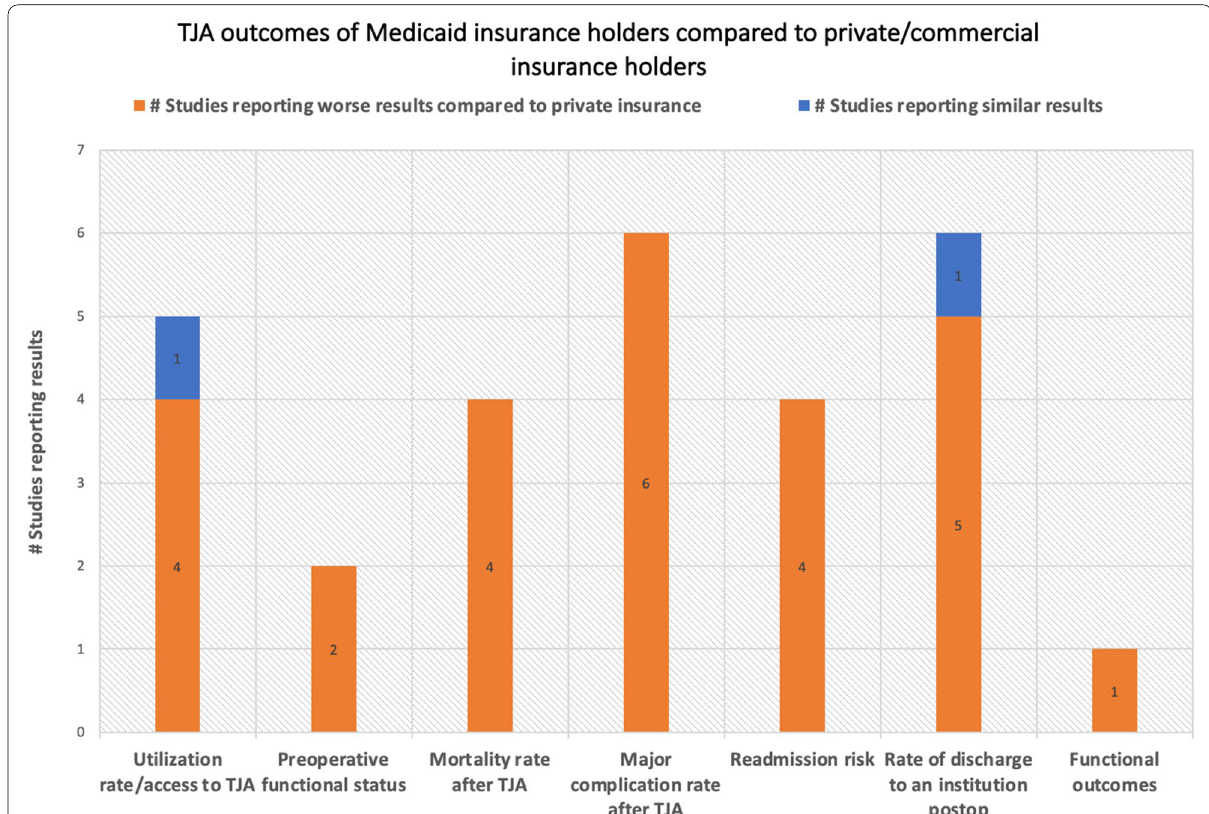
Fig. 2 TJA outcomes of Medicaid compared to private/commercial insurance